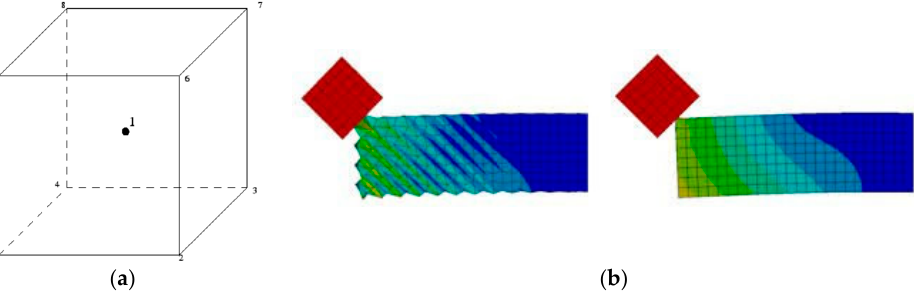
Figure 6. C3D8R linear brick element ( a ) and effects of hourglass control ( b ).